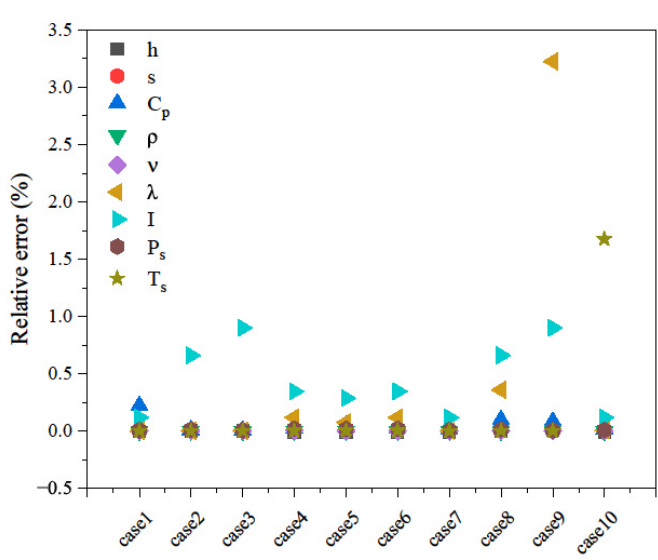
Figure 3. Relative error in 𝑓(𝑝, 𝑇) .